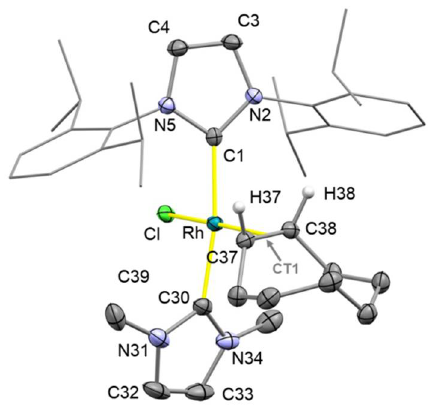
Figure 1. ORTEP view of 3a . For clarity, most hydrogen atoms are omitted and selected groups are shown in a wireframe style. Thermal ellipsoids are at 50% probability. Selected bond lengths (Å) and angles (°) are: Rh-C1 2.061(2), Rh-C30 2.030(2), Rh-Cl 2.4215(6), Rh-CT1 2.0050(2), C37-C38 1.405(3), C1-Rh-C30 169.65(9), C30-Rh-Cl 82.13(7), C1-Rh-Cl 89.07(6), CT1-Rh-Cl 169.320(18). CT1, centroid of C37 and C38. IPr: pitch angle (θ) 5.1, yaw angle (ψ) 4.1; Ime: pitch angle (θ) 9.3, yaw